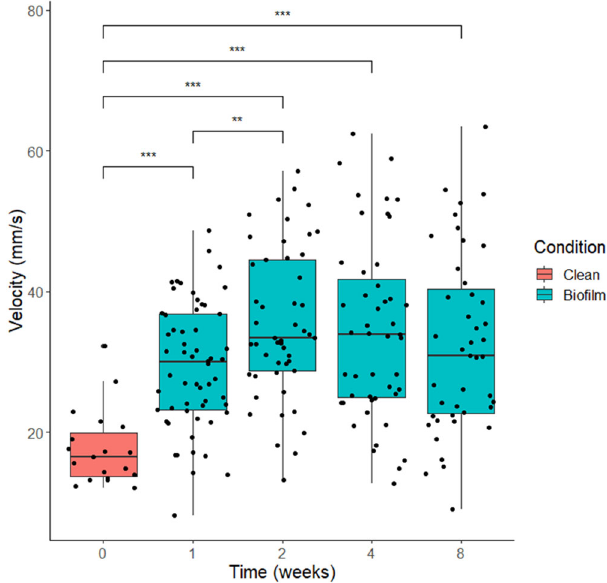
Fig. 3 Changes in settling velocity of polyethylene terephthalate (PET) fragments over time (0 – 8 weeks) due to bio fi lm growth. Clean particles are indicated by the red box while bio fi lmed particles are represented by the blue boxplots. The boxes represent the interquartile range where the line within each box represents the median and the whiskers represent the minimum and maximum. Brackets demonstrate statistical signi fi cance: *** p < 0.001 and ** p < 0.05 ( n = 216).